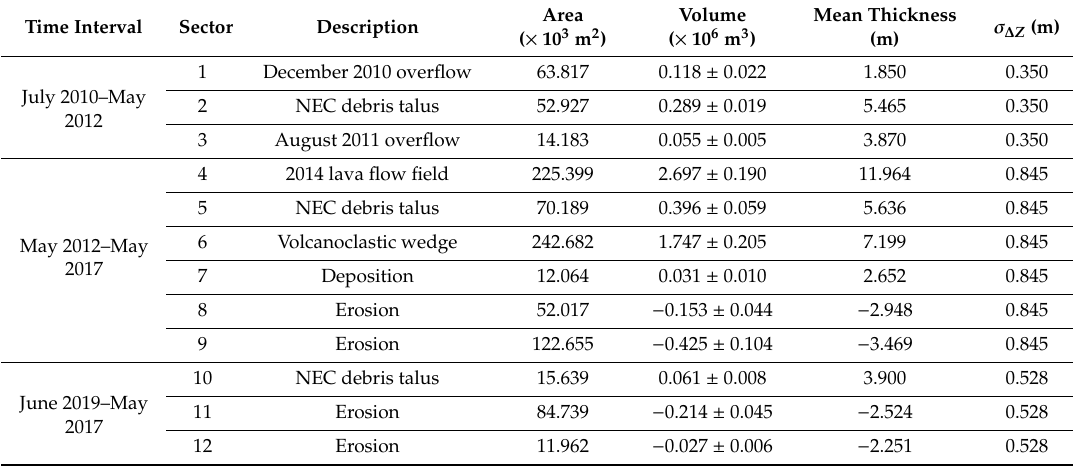
Figure 4. Sciara del Fuoco topographic change detections. ( a ) May 2012 Light Detection and Ranging (LiDAR) vs. July 2010 LiDAR digital elevation models (DEMs) comparison. ( b ) May 2012 LiDAR vs. May 2017 PL É IADES DEMs comparison. ( c ) September 2019 PL É IADES vs. May 2017 PL É IADES DEMs comparison. Dashed lines outline the areas where the volume gain and loss were calculated. ( d ) September 2018 PL É IADES vs. July 2010 LiDAR comparison throughout the investigated time interval. P1, P2 and P3 refer to the profile of Figure 5. Table 6. Topographic change detection